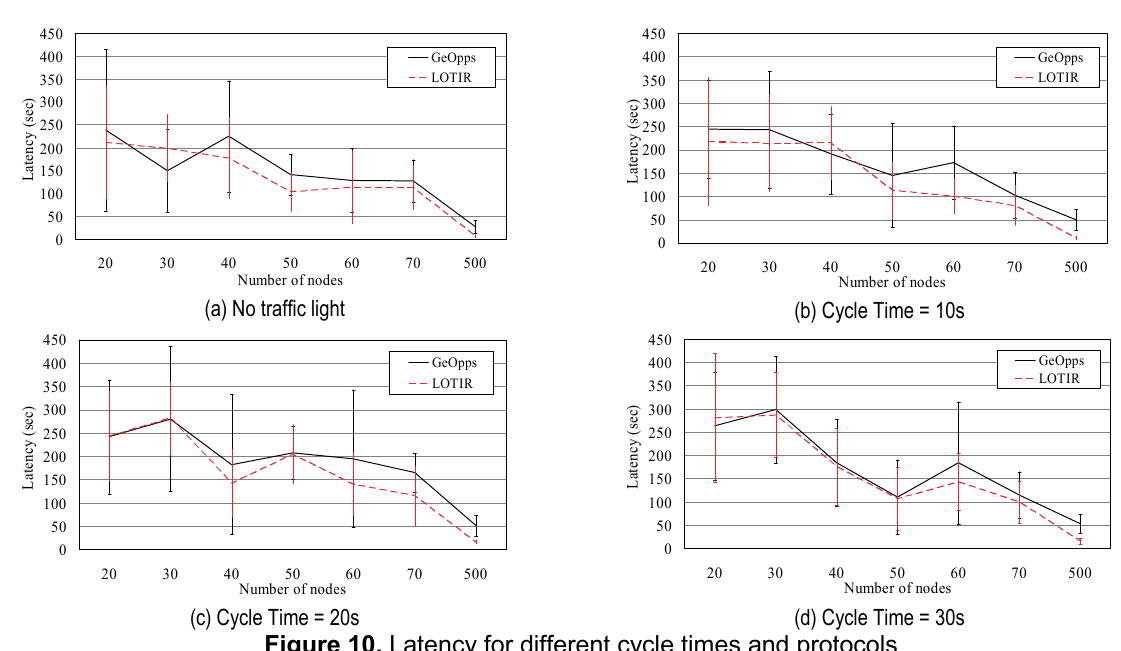
Figure 10. Latency for different cycle times and